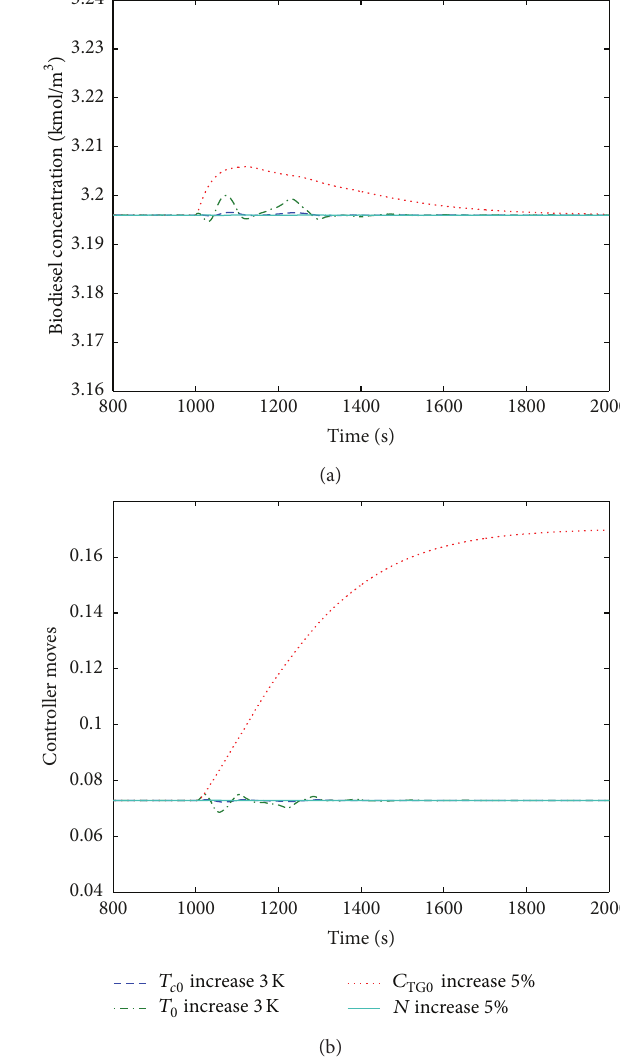
Figure 12: Biodiesel concentration and controller moves of four individual disturbance variables